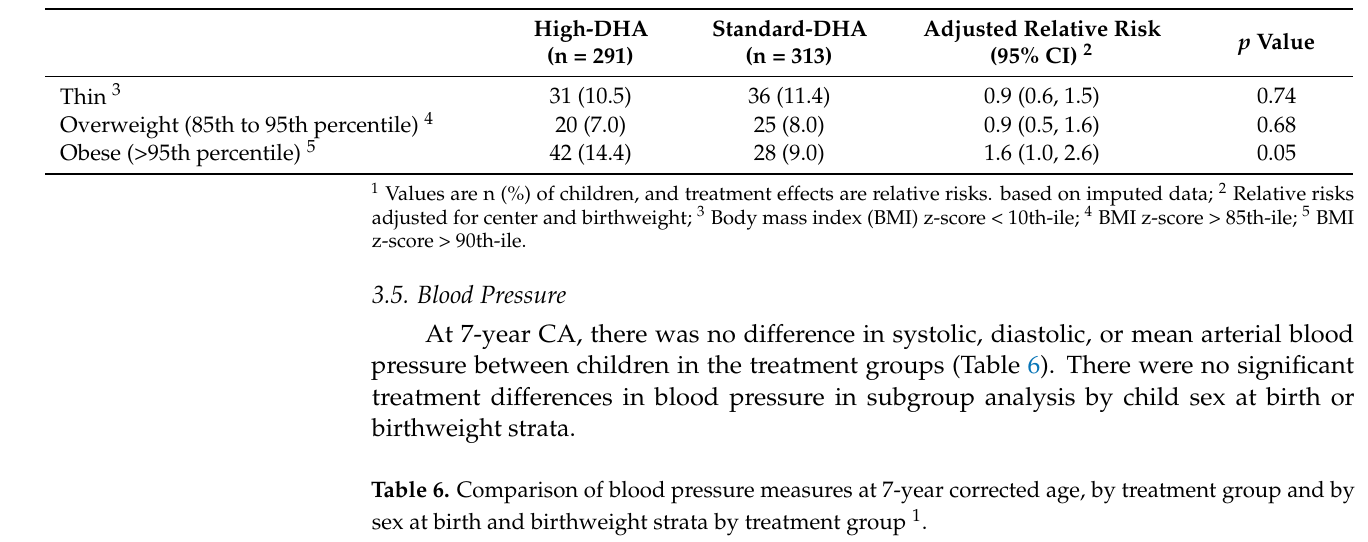
Table 5. Weight status at 7-year corrected age by treatment group 1 .